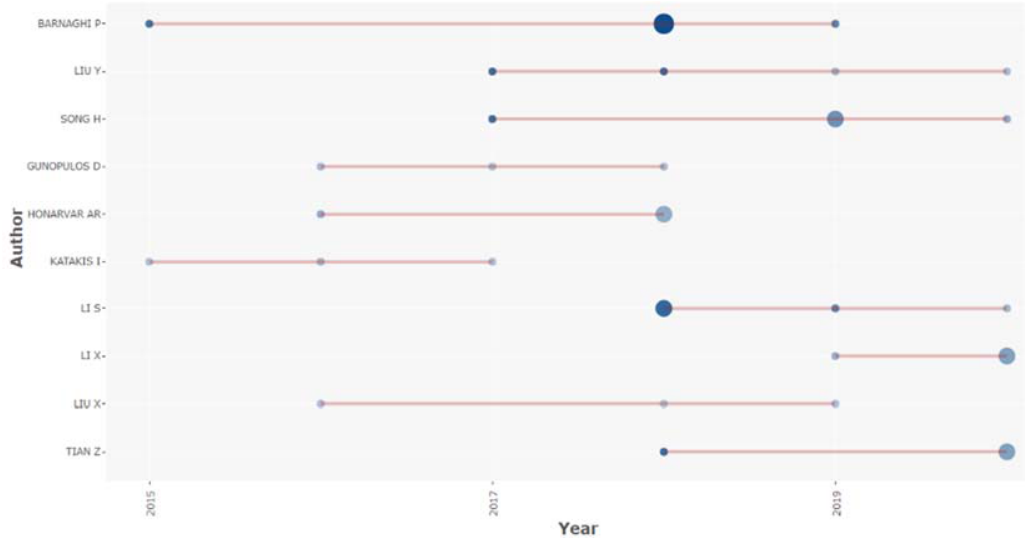
Figure 7. Author production over time.